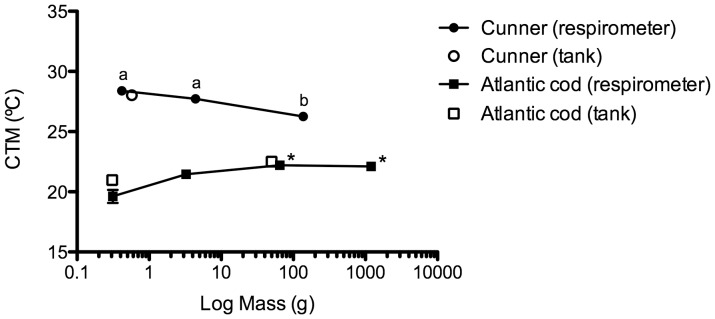
The relationship between body mass and CTMax in cunner and Atlantic cod.An asterisk (*) indicates data plotted from previous studies ([22]; Gamperl and Canada, unpublished), whereas dissimilar letters indicate a significant difference (P<0.05) in CTMax values between the three size classes of cunner. Note: the CTMax values for YOY Atlantic cod (∼0.3 g) tested in the respirometer and the tank were significantly different (P<0.05). Values are mean ± 1 S.E.